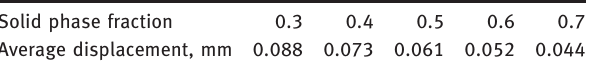
Table 2: Average displacement of solidification front under different solid phase